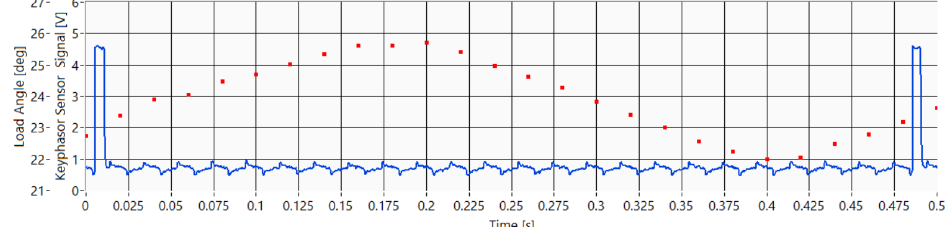
Figure 13. Results of the load angle measurement when the load angle correction function is not applied. The red dots represent the load angle values, and the blue curve the output of the keyphasor sensor.